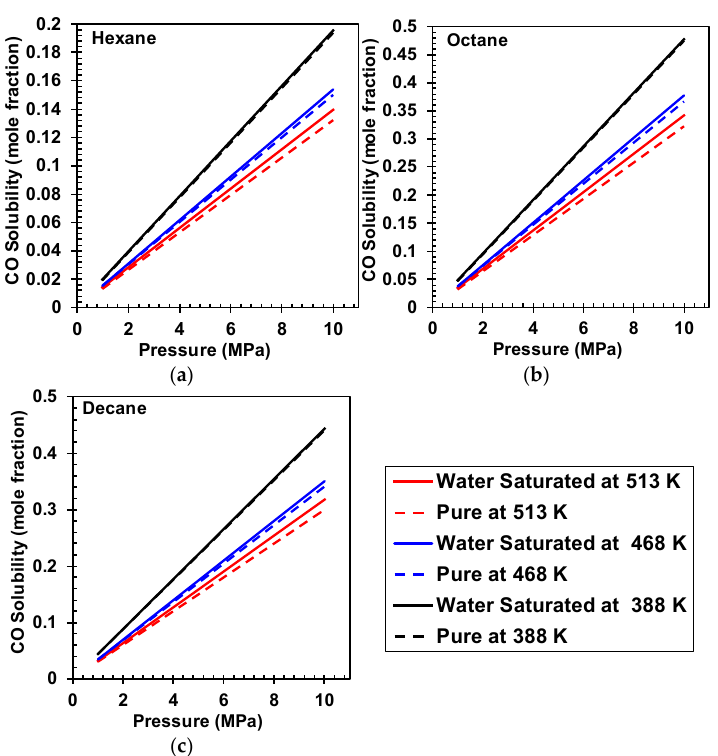
Figure 3. Comparing CO solubility in pure and water saturated ( a ) Hexane, ( b ) Octane, and ( c ) Decane at various temperatures.